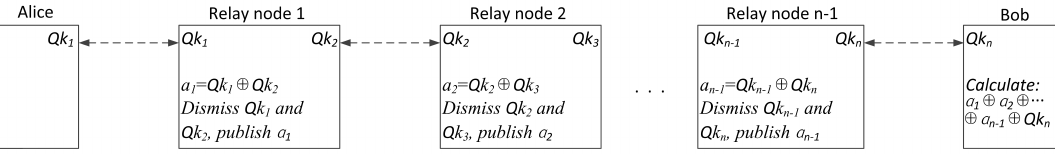
Figure 2. The model of public-XOR-key scheme with two endpoints. The dotted arrow stands for